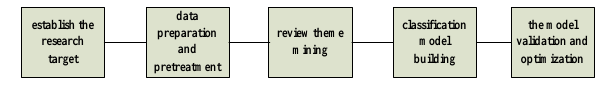
Figure 1. clothing reviews mining research flow